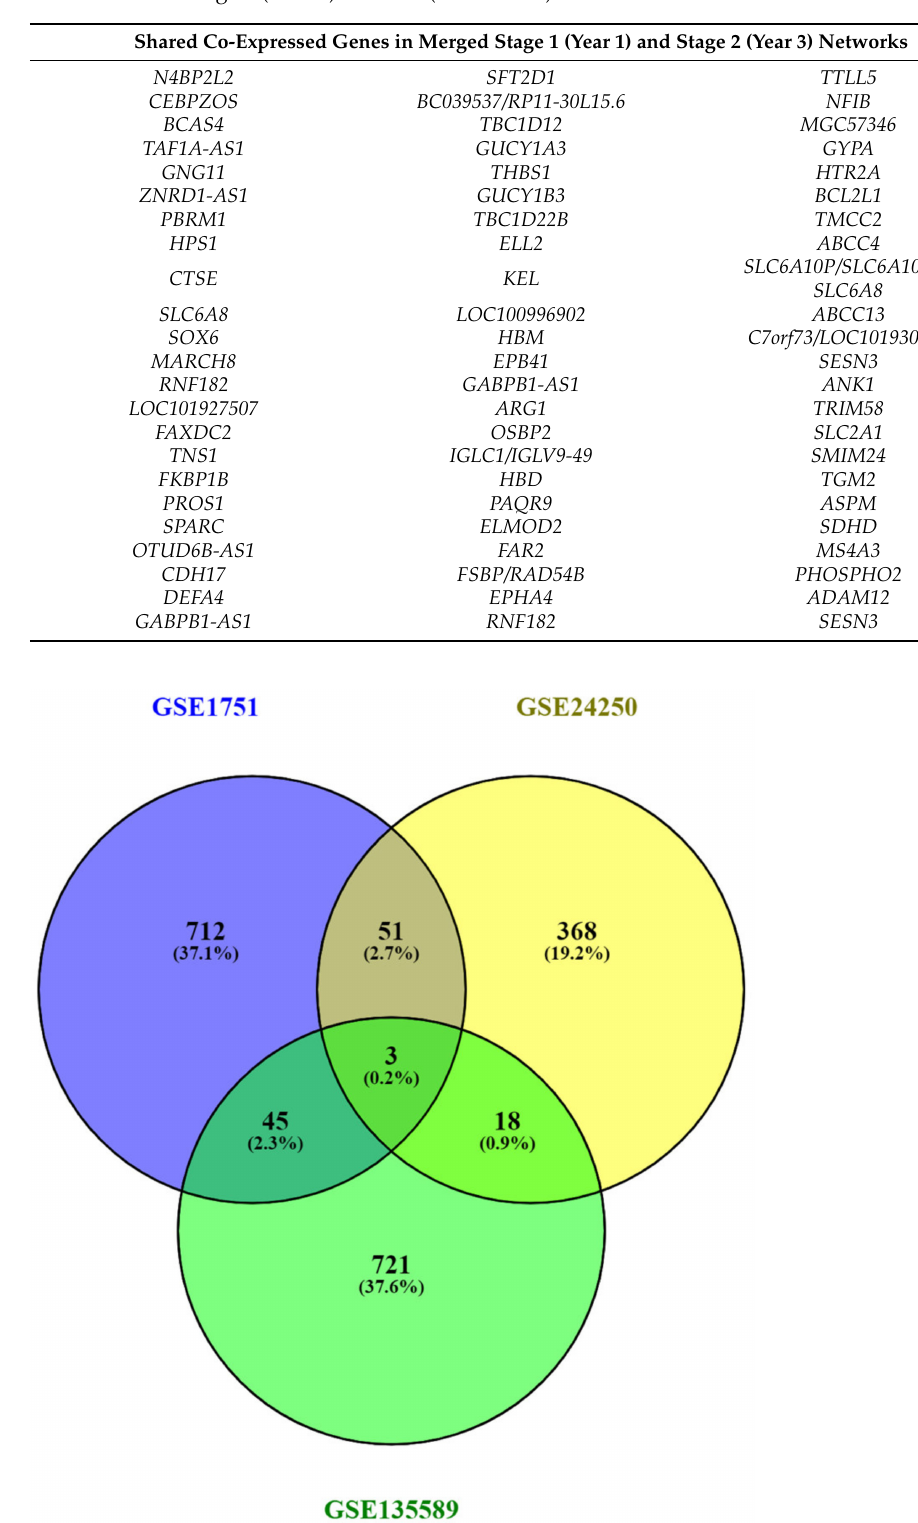
Table 3. Shared co-expressed genes in merged networks for controls versus Stage 1 (Year 1) and controls versus Stage 2 (Year 3) datasets (GSE135589).